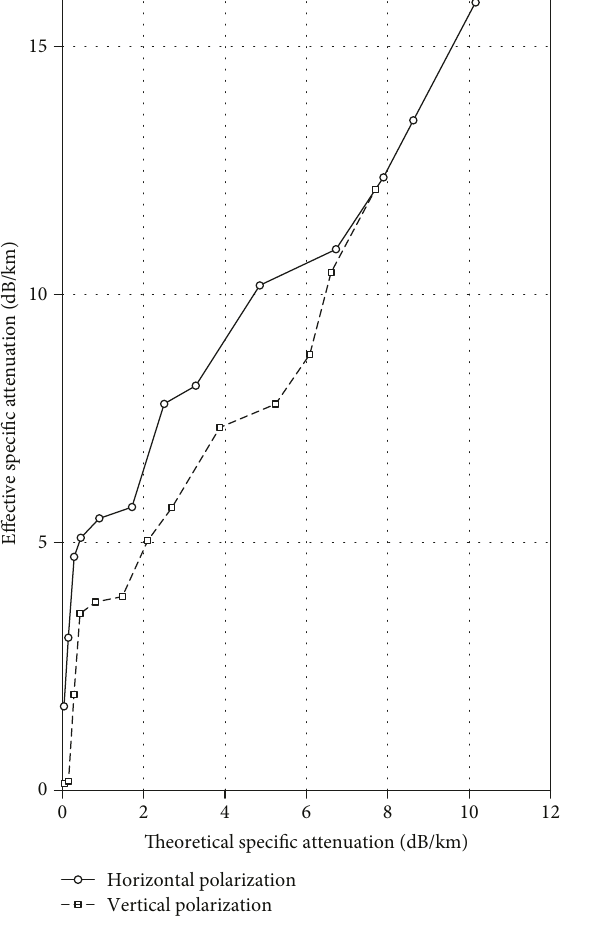
Figure 8: Comparison of e ff ective and theoretical speci fi c rain attenuation